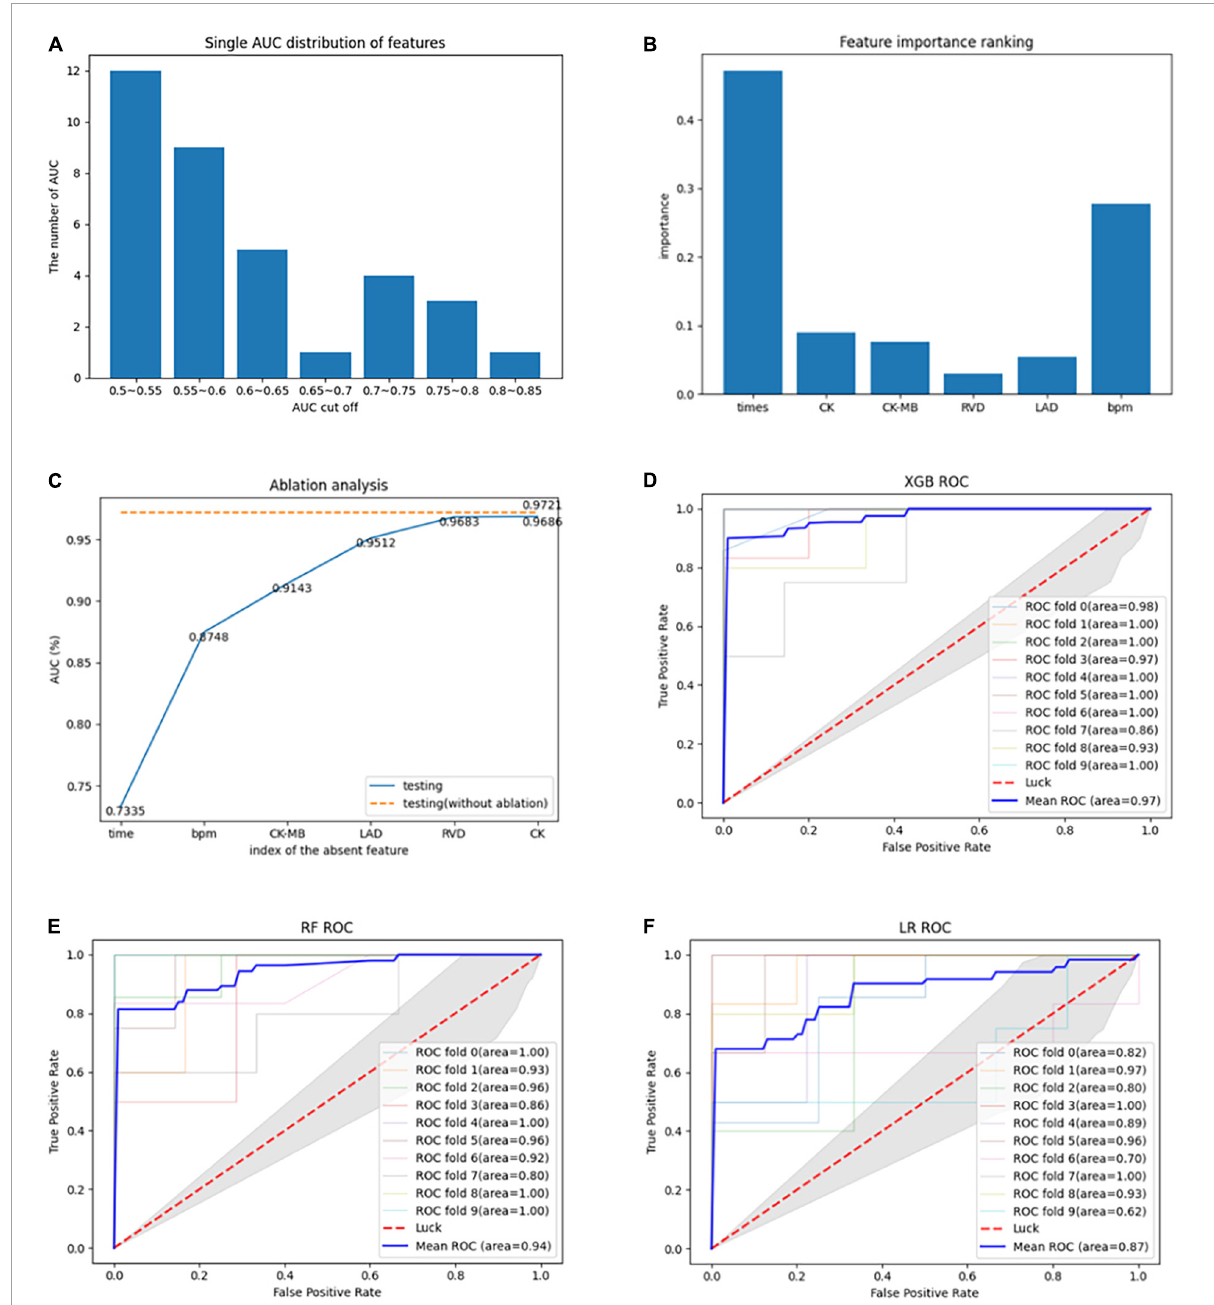
FIGURE2 (A) AUC values of each feature for classification during the modeling process. (B) Importance ranking of the optimal features derived by the greedy algorithm. (C) Evaluation of the contribution of each feature to the model through ablation analysis. (D) ROC curve of 10-fold cross-validation using extreme gradient boosting algorithm. (E) ROC curve of 10-fold cross-validation using random forest algorithm. (F) ROC curve of 10-fold cross-validation using logistic regression